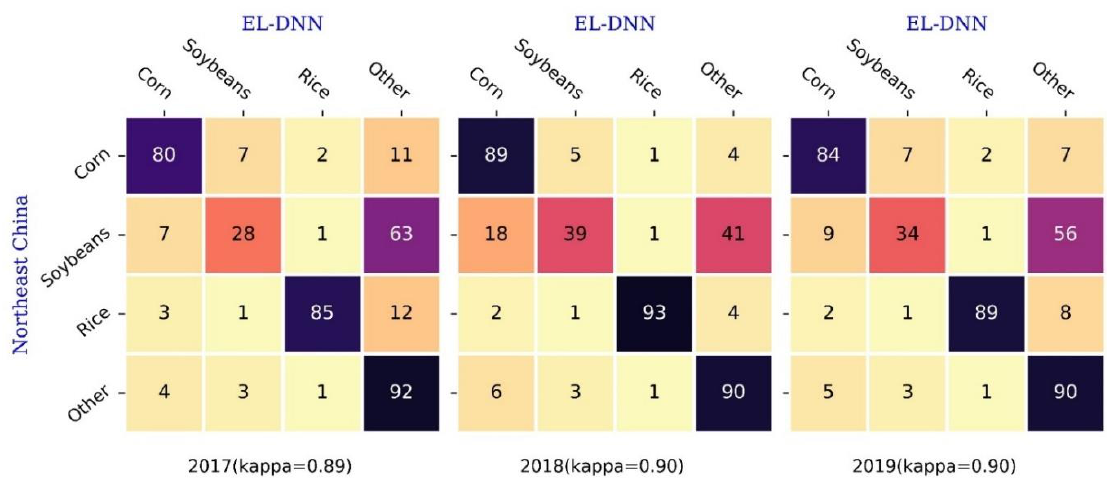
Figure 7. Normalized confusion matrix assuming Northeast China is true from 2017 to